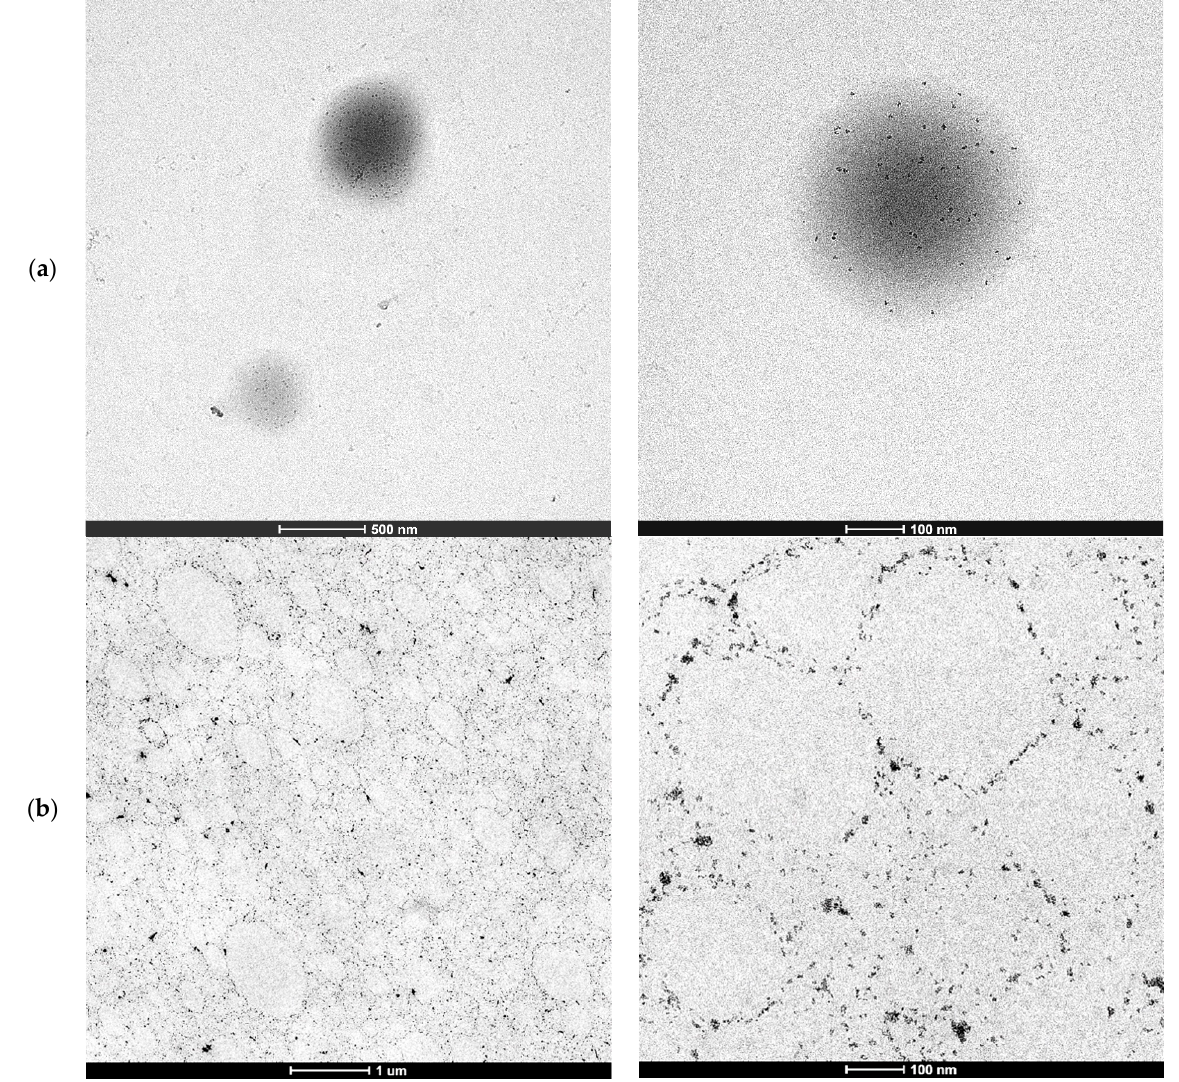
Figure 1. TEM micrographs of the hybrid CeO 2 -Bioacrylic latex polymer particles ( a ) and hybrid CeO 2 -Bioacrylic film ( b ).